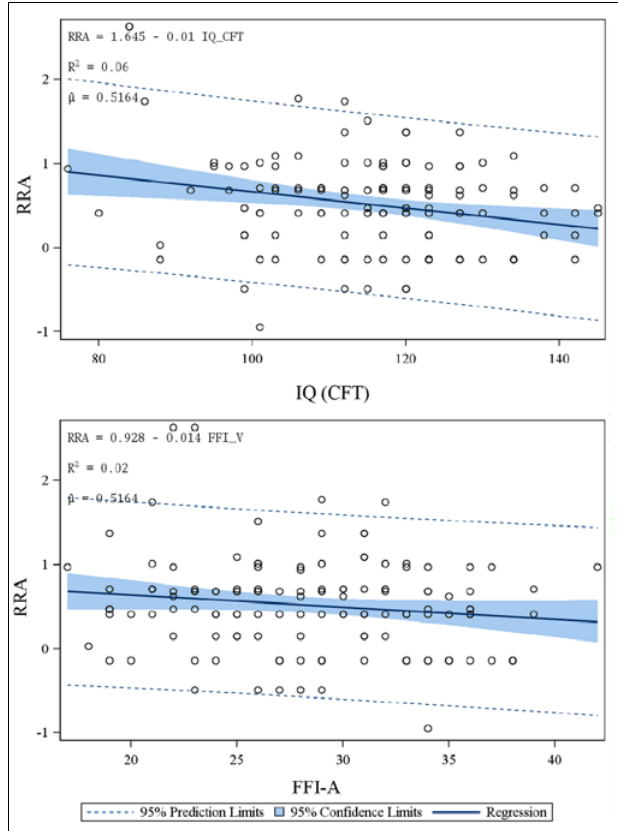
FIGURE 4 | Simple linear regressions after exclusion of six individual datasets according to the check for parameter instability and restricted maximum likelihood effects (proc-mixed, SAS). Depicted are individual observations for RRA plotted versus the intelligence quotient measured by the culture free intelligence task (CFT) and the NEO-FFI agreeableness score (FFI-A). Furthermore, the 95% prediction limits (dotted lines) and the 95% confidence limits (blue area) are